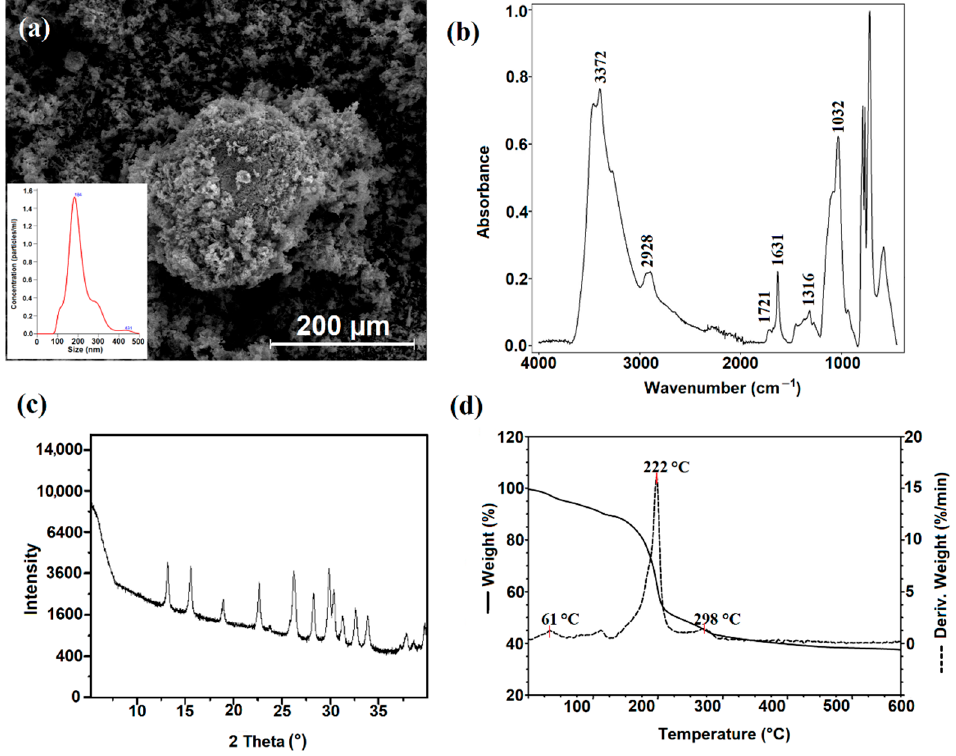
Figure 3. ( a ) SEM image, with inset showing the size distributions and particle concentrations of dialdehyde starch nanocrystals; ( b ) ATR-FTIR spectra; ( c ) the X-ray diffraction (XRD) patterns; and ( d ) the TGA-DTG curves of dialdehyde starch nanocrystals.